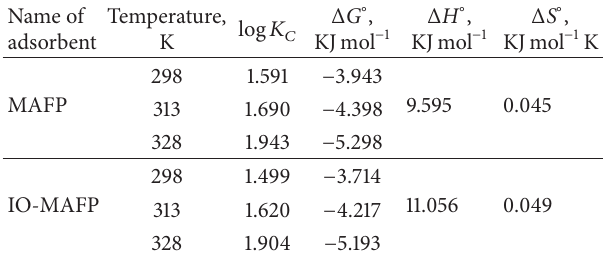
Figure 13: Biosoption thermodynamics of Co(II) onto MAFP and IO-MAFP biomasses. Table 5: Thermodynamic parameters of Co(II) biosorption on MAFP and